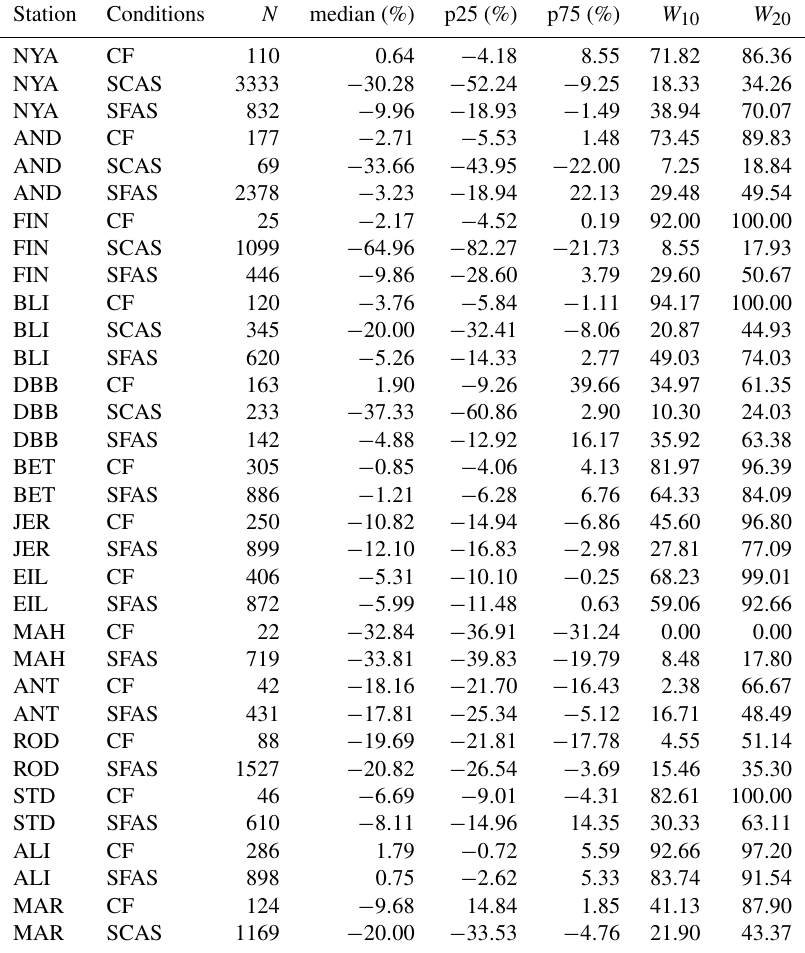
Table 6. TROPOMI overpass UV index/erythemally weighted dose rates compared to broadband and multichannel radiometer measure- ments. The percentage relative differences 100% × ( sat − gr )/ gr, their medians (median), and the 25th (p25) and 75th (p75) percentiles were calculated. N is the number of measurement days included in the study. W 10 and W 20 are the percentages of satellite data which are within 10% and 20% of ground measurements. CF: cloud-free; SCAS: snow cover at ground, all sky; SFAS: snow-free ground, all